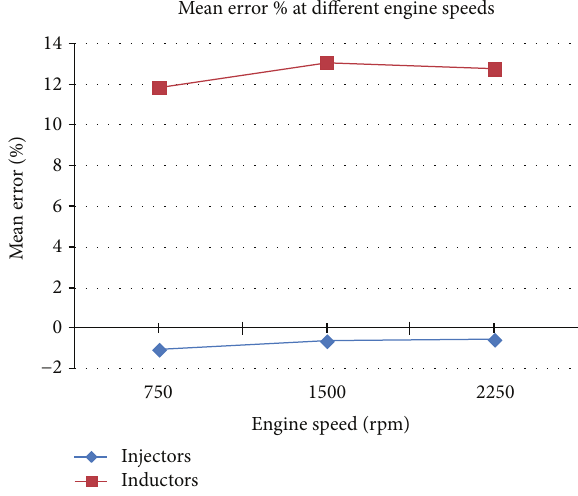
Figure 9: Comparing error % against fueling quantity for injectors and